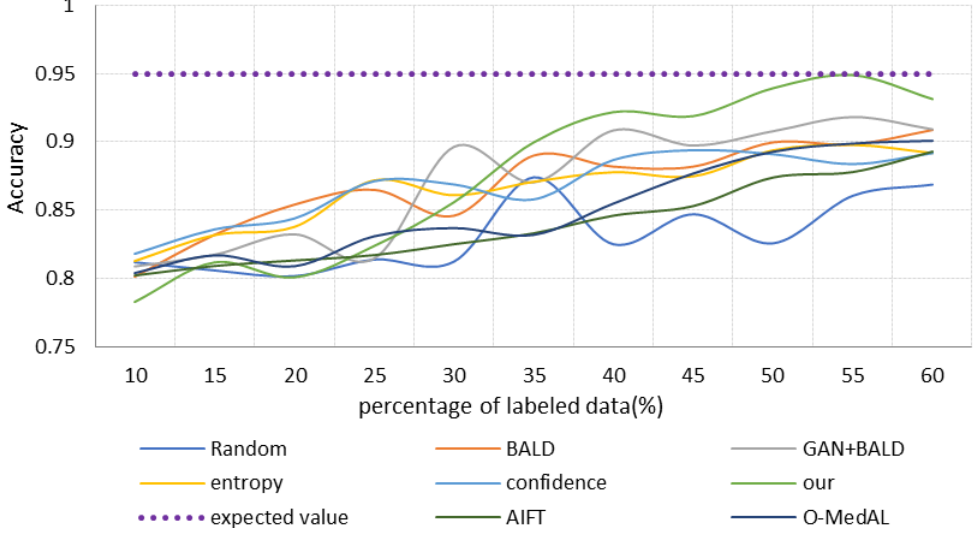
Figure 8. Accuracy with the increase of iterations.